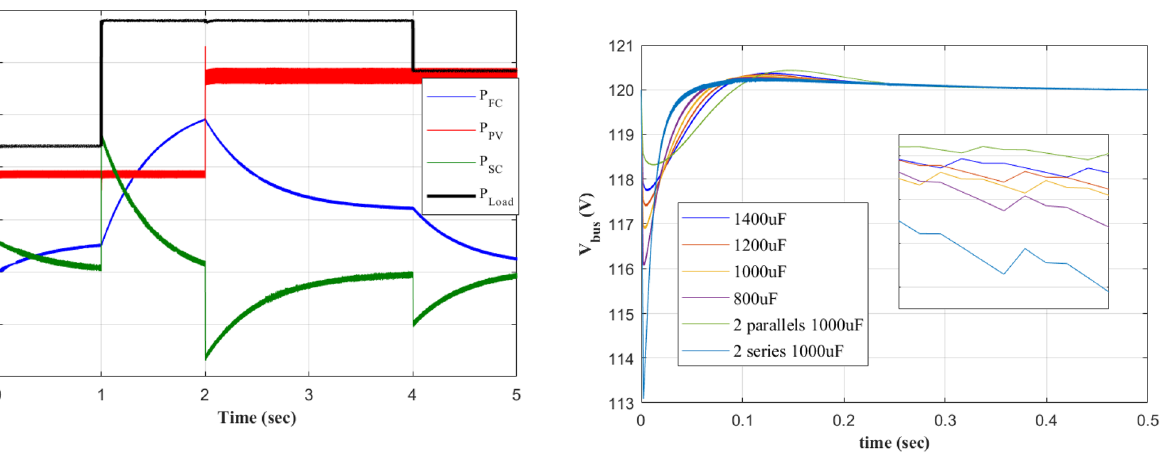
Fig. 15 Bus voltage with different Cbus